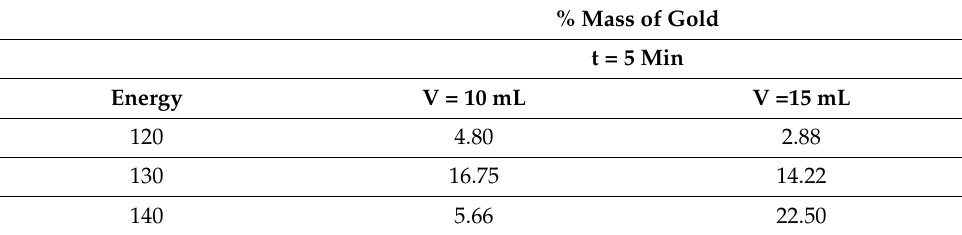
Table 3. Mass percentage of gold in the sample medium with 10 and 15 mL (retrieved with permission from reference [5]).